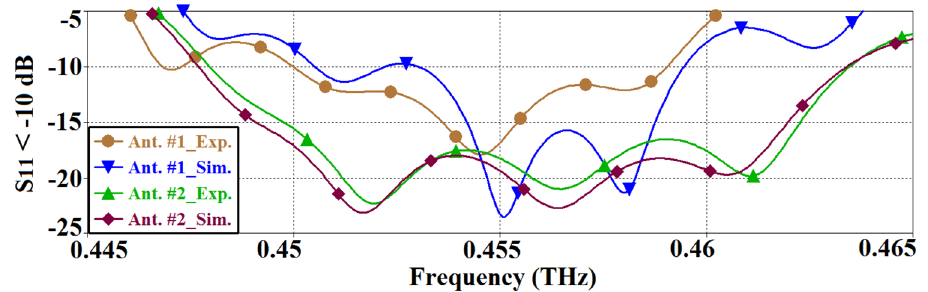
Figure 6. Simulated and measured reflection-coefficient response of the SIW-inspired AoC (Ant. #1) and the SIW-MTS inspired version (Ant.